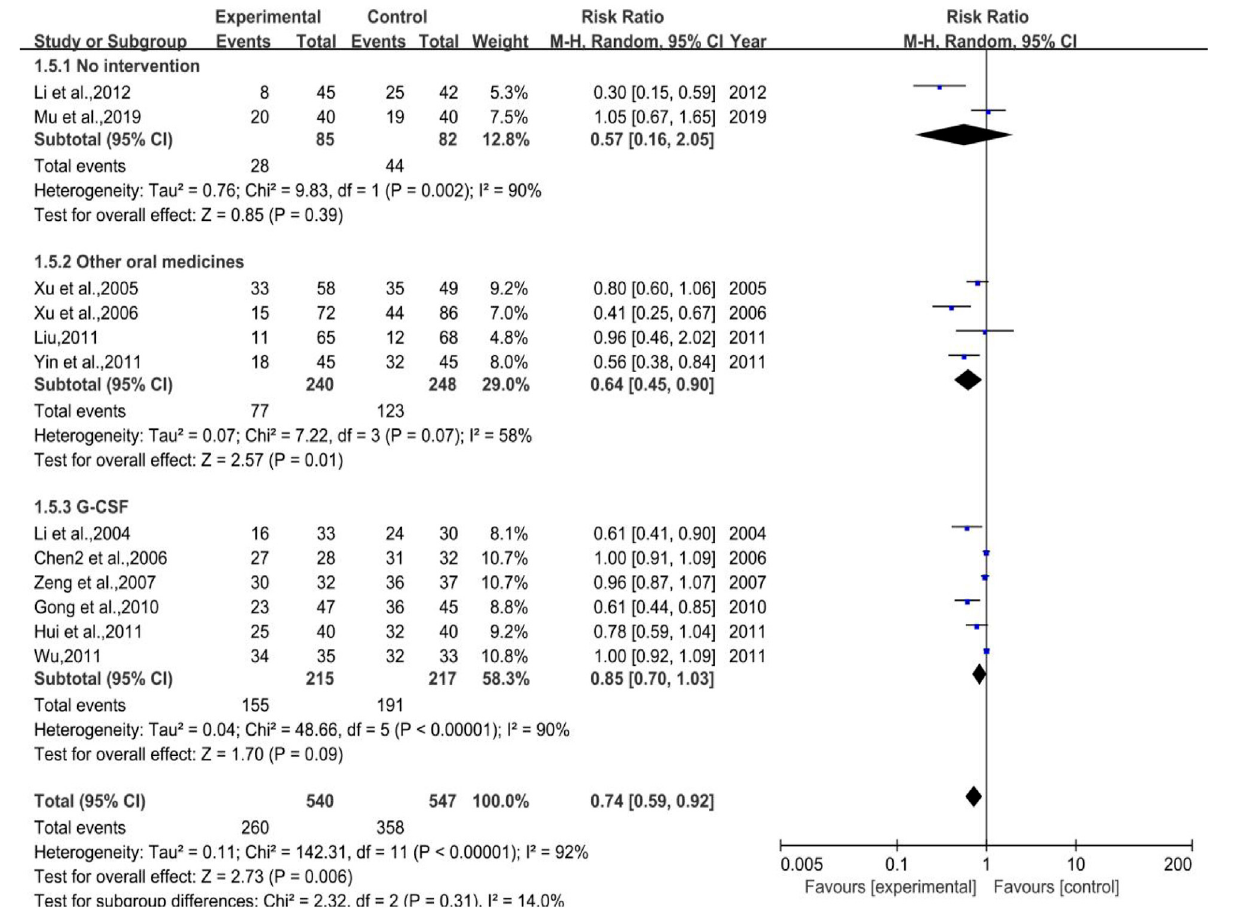
Frontiers in Pharmacology |